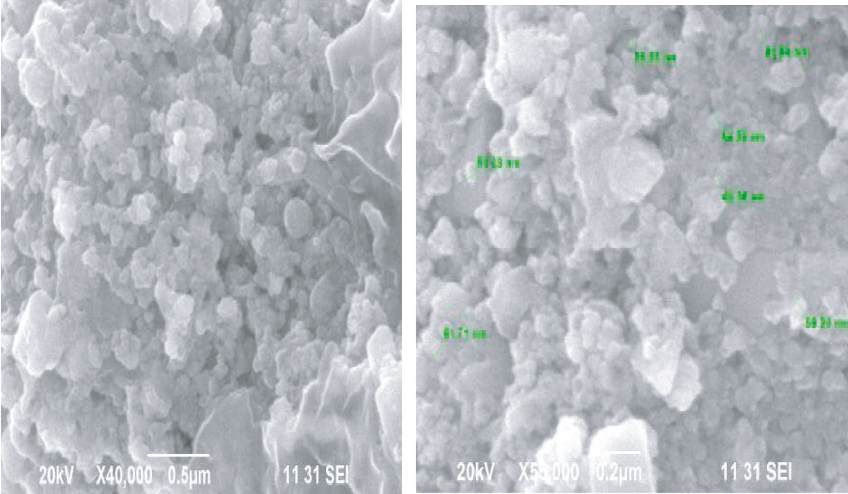
Figure 4: SEM image for synthesized silver nanoparticles using the Pisonia Alba leaf extract.